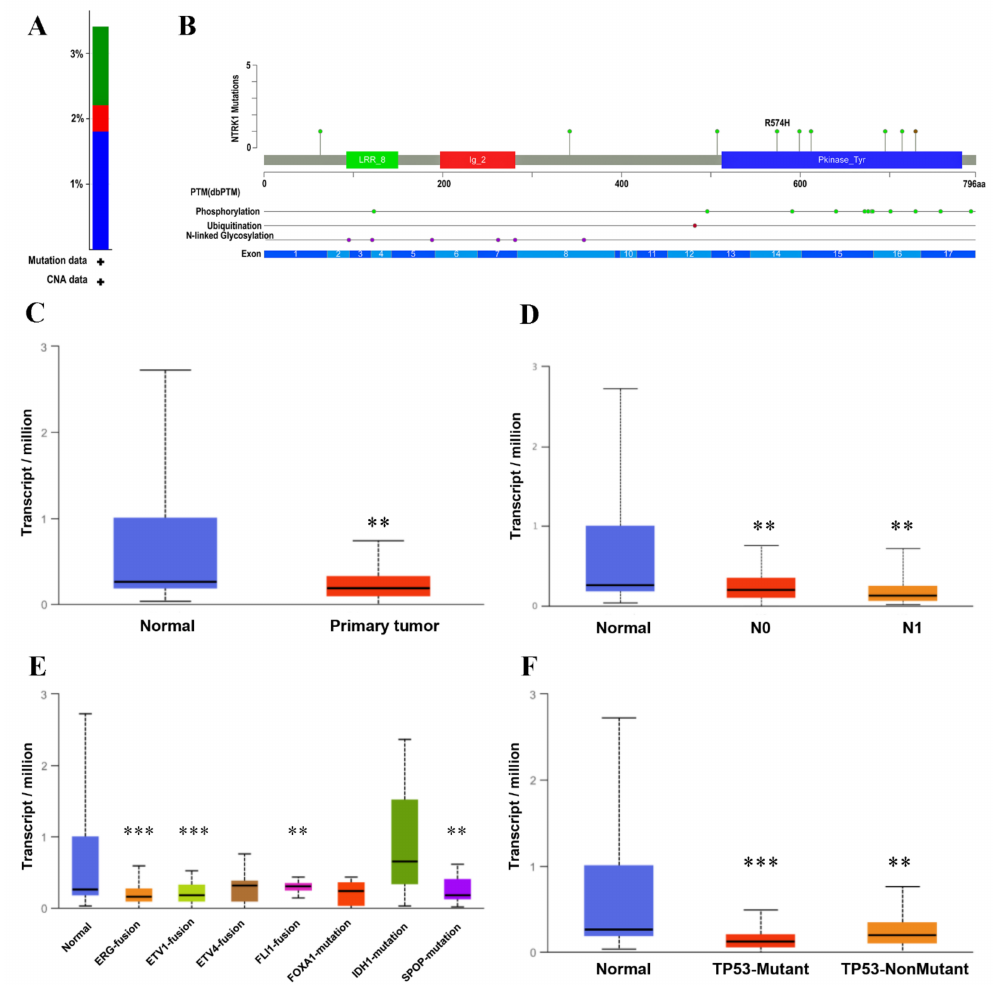
Figure 8. The validation of NTRK1 using the UALCAN and cBioPortal databases. ( A ) The barplot shows the alteration frequency of NTRK1 (3% of 499 PRAD cases) across the TCGA-PRAD dataset (TCGA, Firehose Legacy). The blue bar depicts 1.8% deep deletions, the green bar depicts 1.2% missense mutations, and the red bar depicts 0.4% amplifications. ( B ) The lollipop plot showing